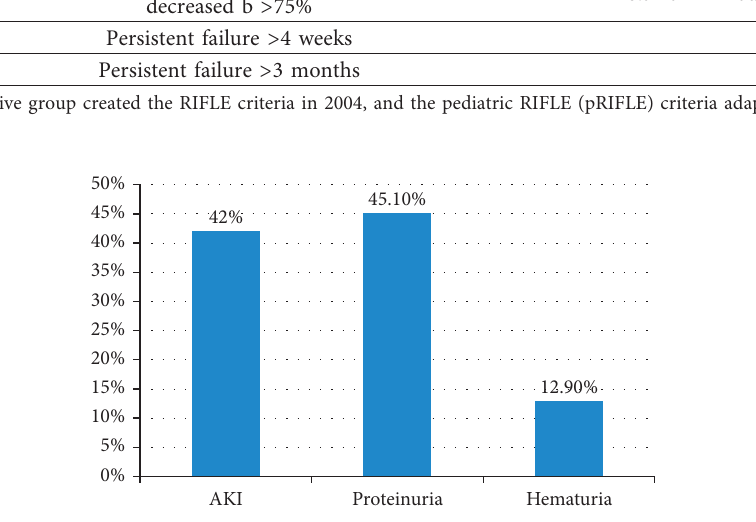
Figure 1: Types of renal involvement in children with dengue fever. Table 2: Renal involvement according to severity of dengue.